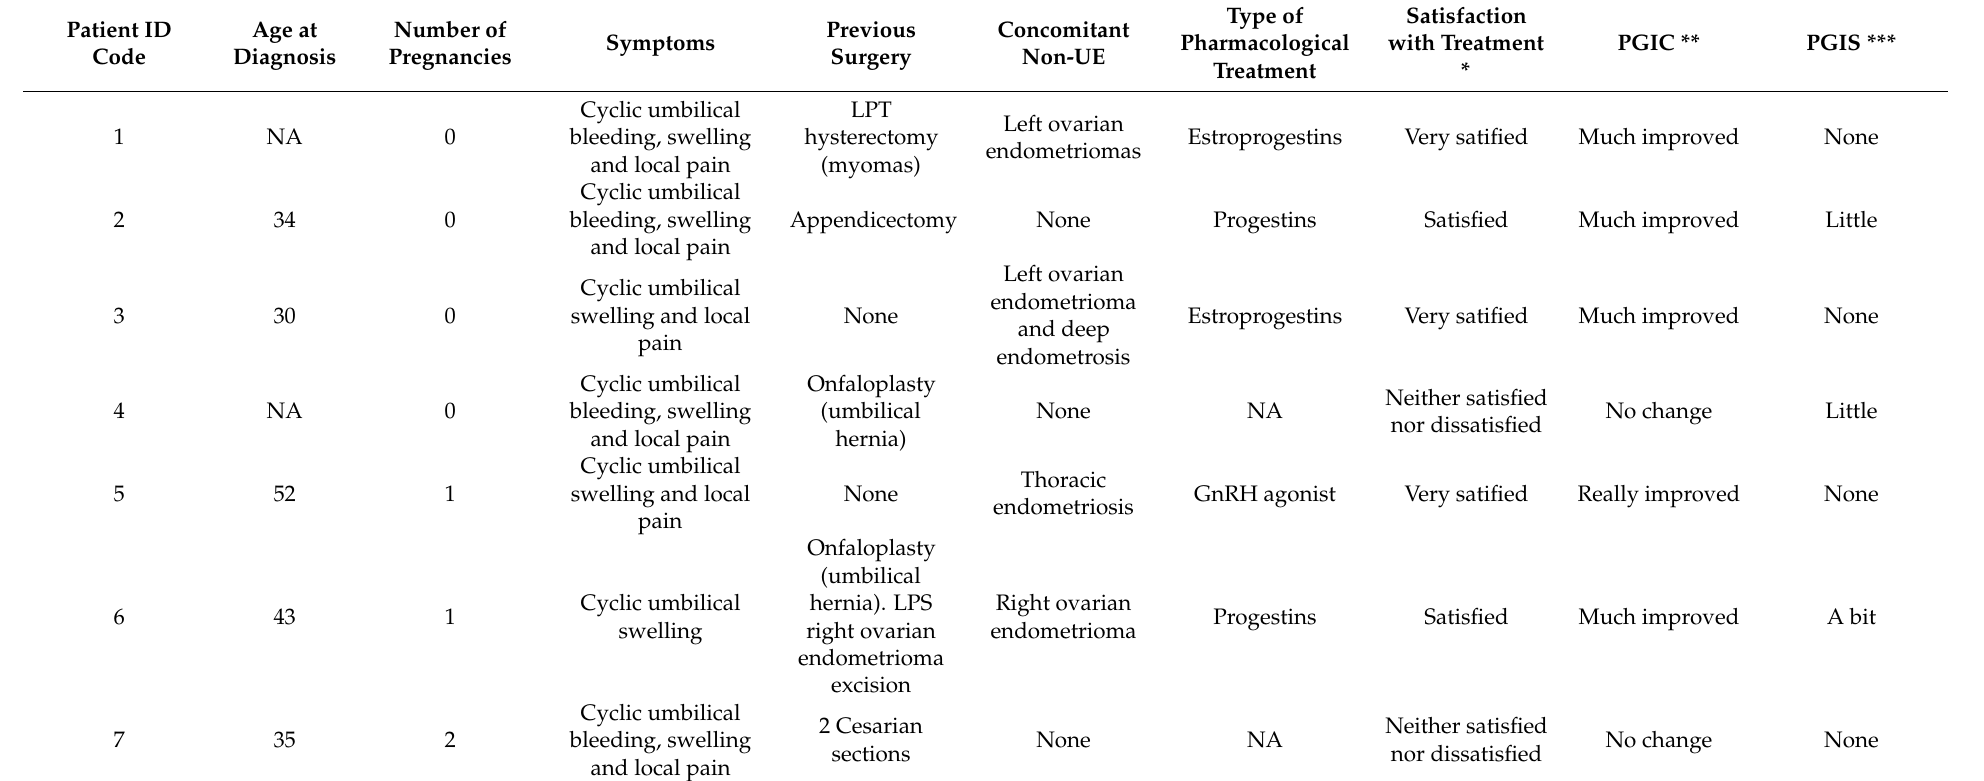
Table 4. Clinical features of women with UE treated with pharmacological therapy and their degrees of satisfaction. Patient